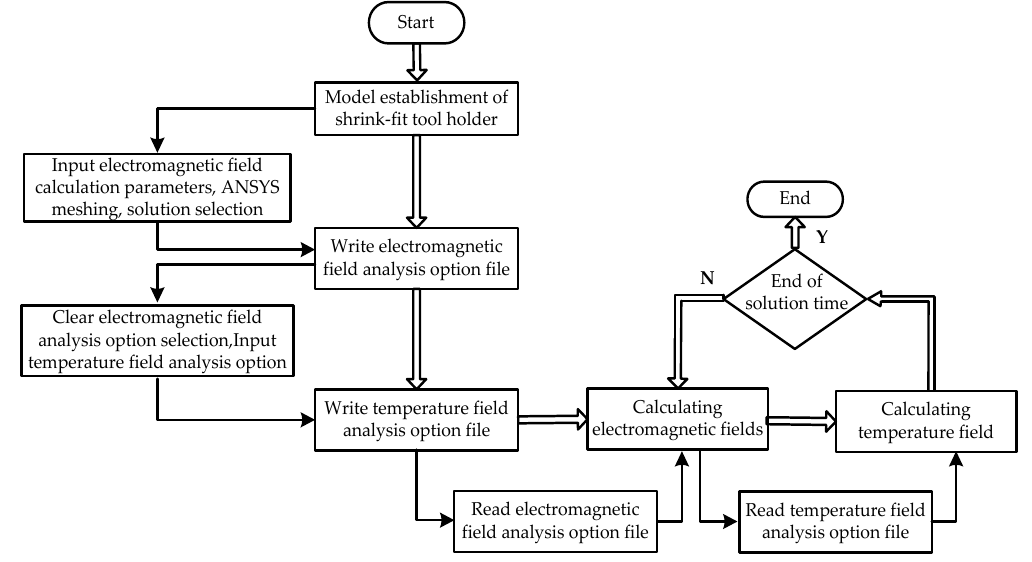
Figure 8. Flow chart of the coupled electro-magnetic-thermal simulation procedure.